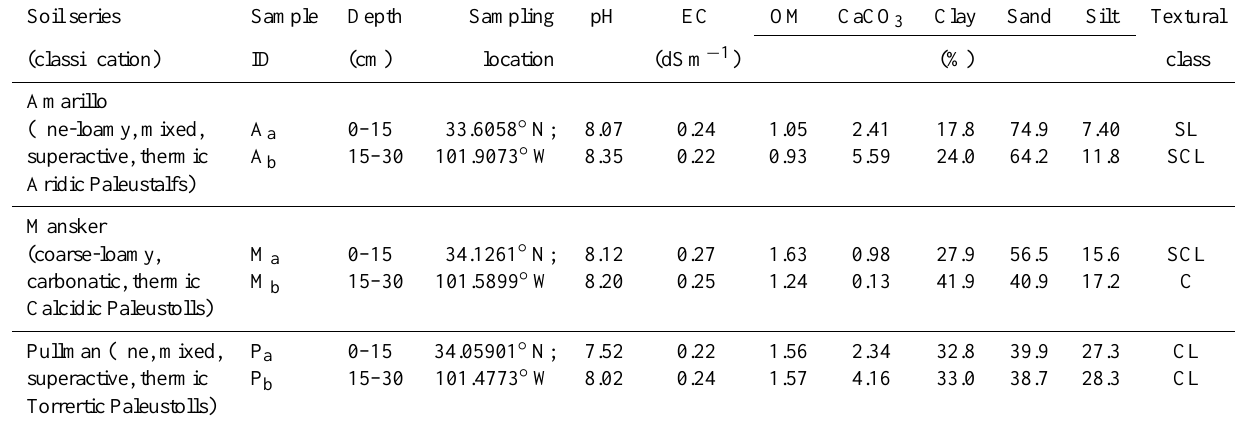
Table 1. Soil classification and identification of selected semiarid alkaline soils of the Southern High Plains, USA. Soil